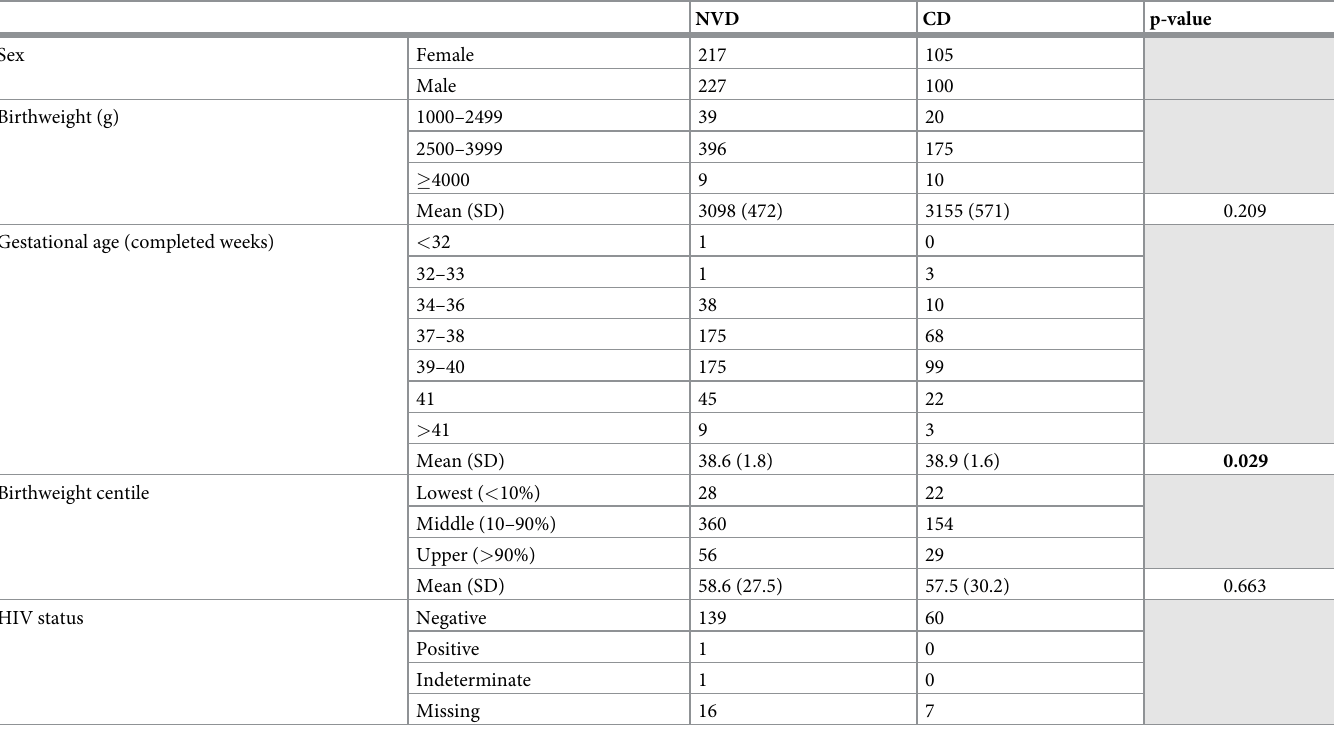
Table 2. Clinical characteristics of neonates.